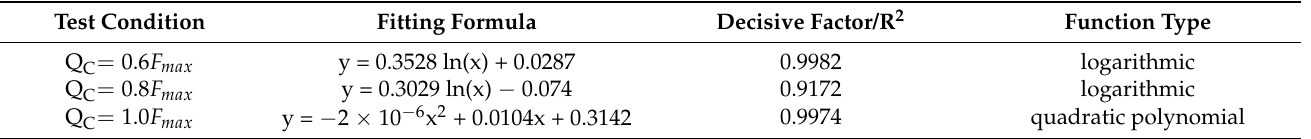
Table 6. Cumulative displacement fitting function for variable loading amplitudes ( θ = 45 ◦